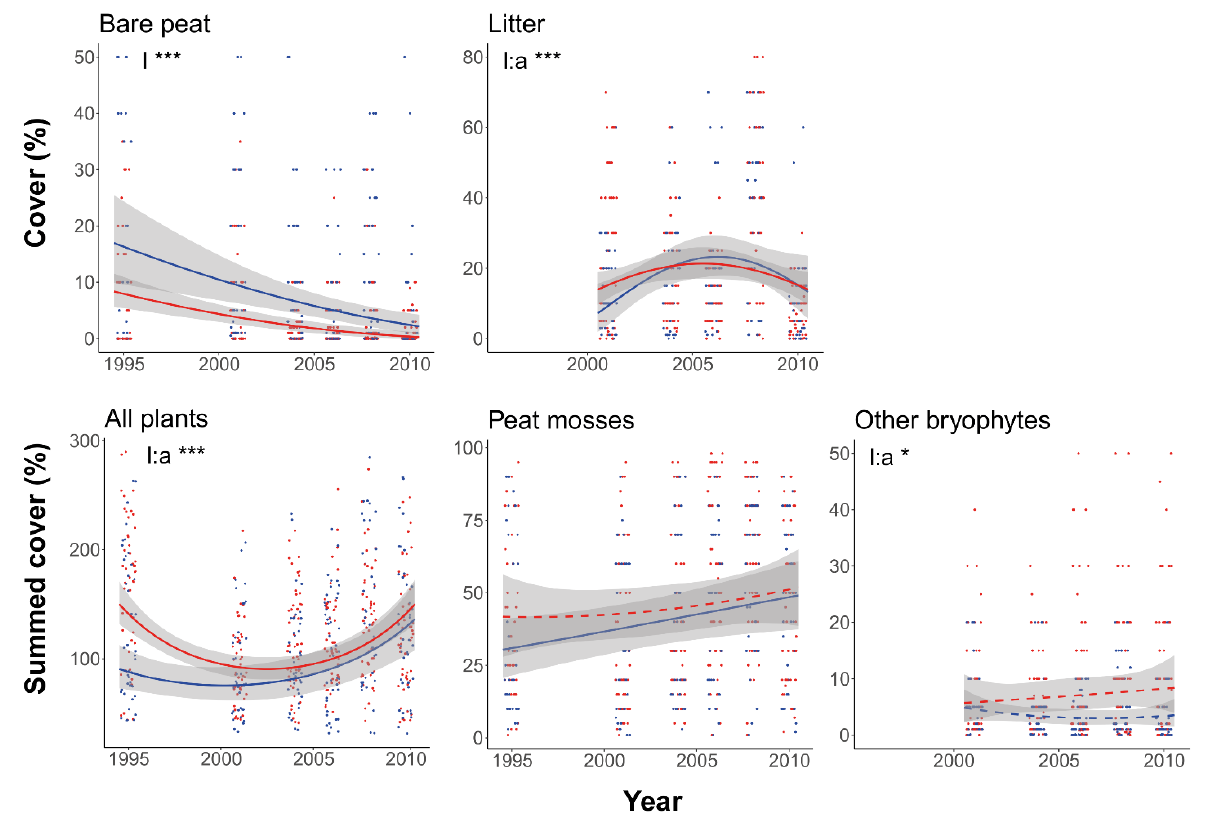
Figure 2. Trends of variables describing the plot structure in percent cover for GC-areas (grazing cessation, red) and GCR-areas (grazing cessation plus rewetting, blue). Regression lines and confidence intervals from individual models are displayed. Solid lines show significant trend components. Dashed lines show the model fit of both trend components, if neither of them is significant. Labels denote significant overall trends or significant interactions between trends and the two areas derived from the common model. Dots indicate observed values on single plots. Outliers are not shown. l = linear time component; q = quadratic time component; a = area type; a colon indicates an interaction. Significance levels: *: p ≤ 0.05; **: p ≤ 0.01; ***: p ≤